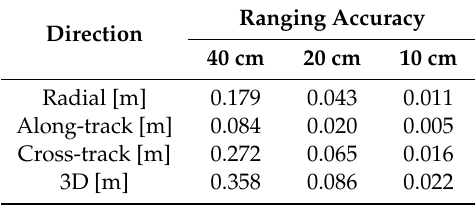
Table 3. Average orbital errors of 60-LEO constellation under di ff erent ranging